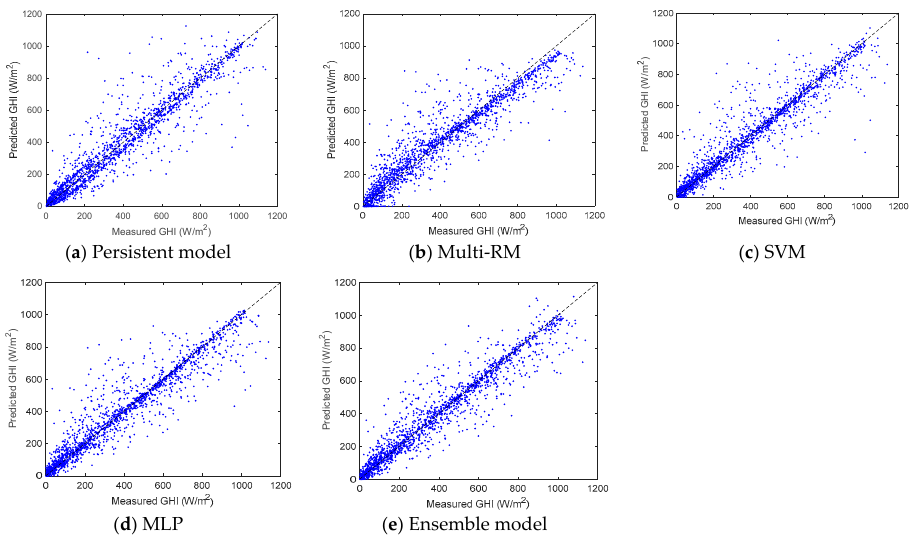
Figure 7. Scatter plots between the predicted GHIs and the measured GHIs in the testing